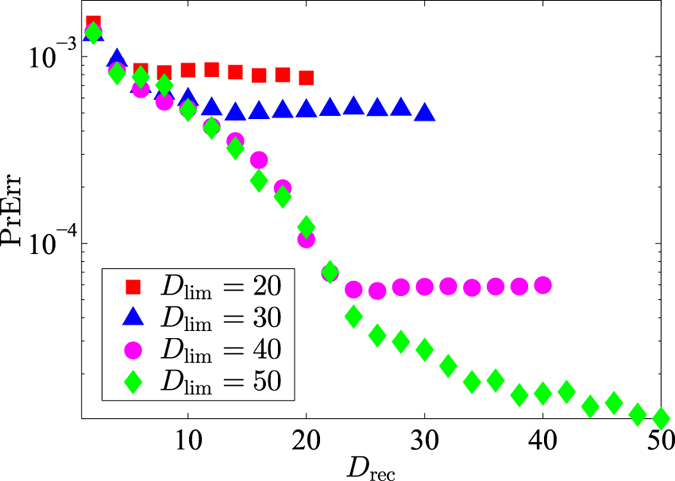
A plot of PrErr (log-scale) against Drec for a fixed set of data and various limit dimensions Dlim.The true state is a coherent state of mean photon number 30.